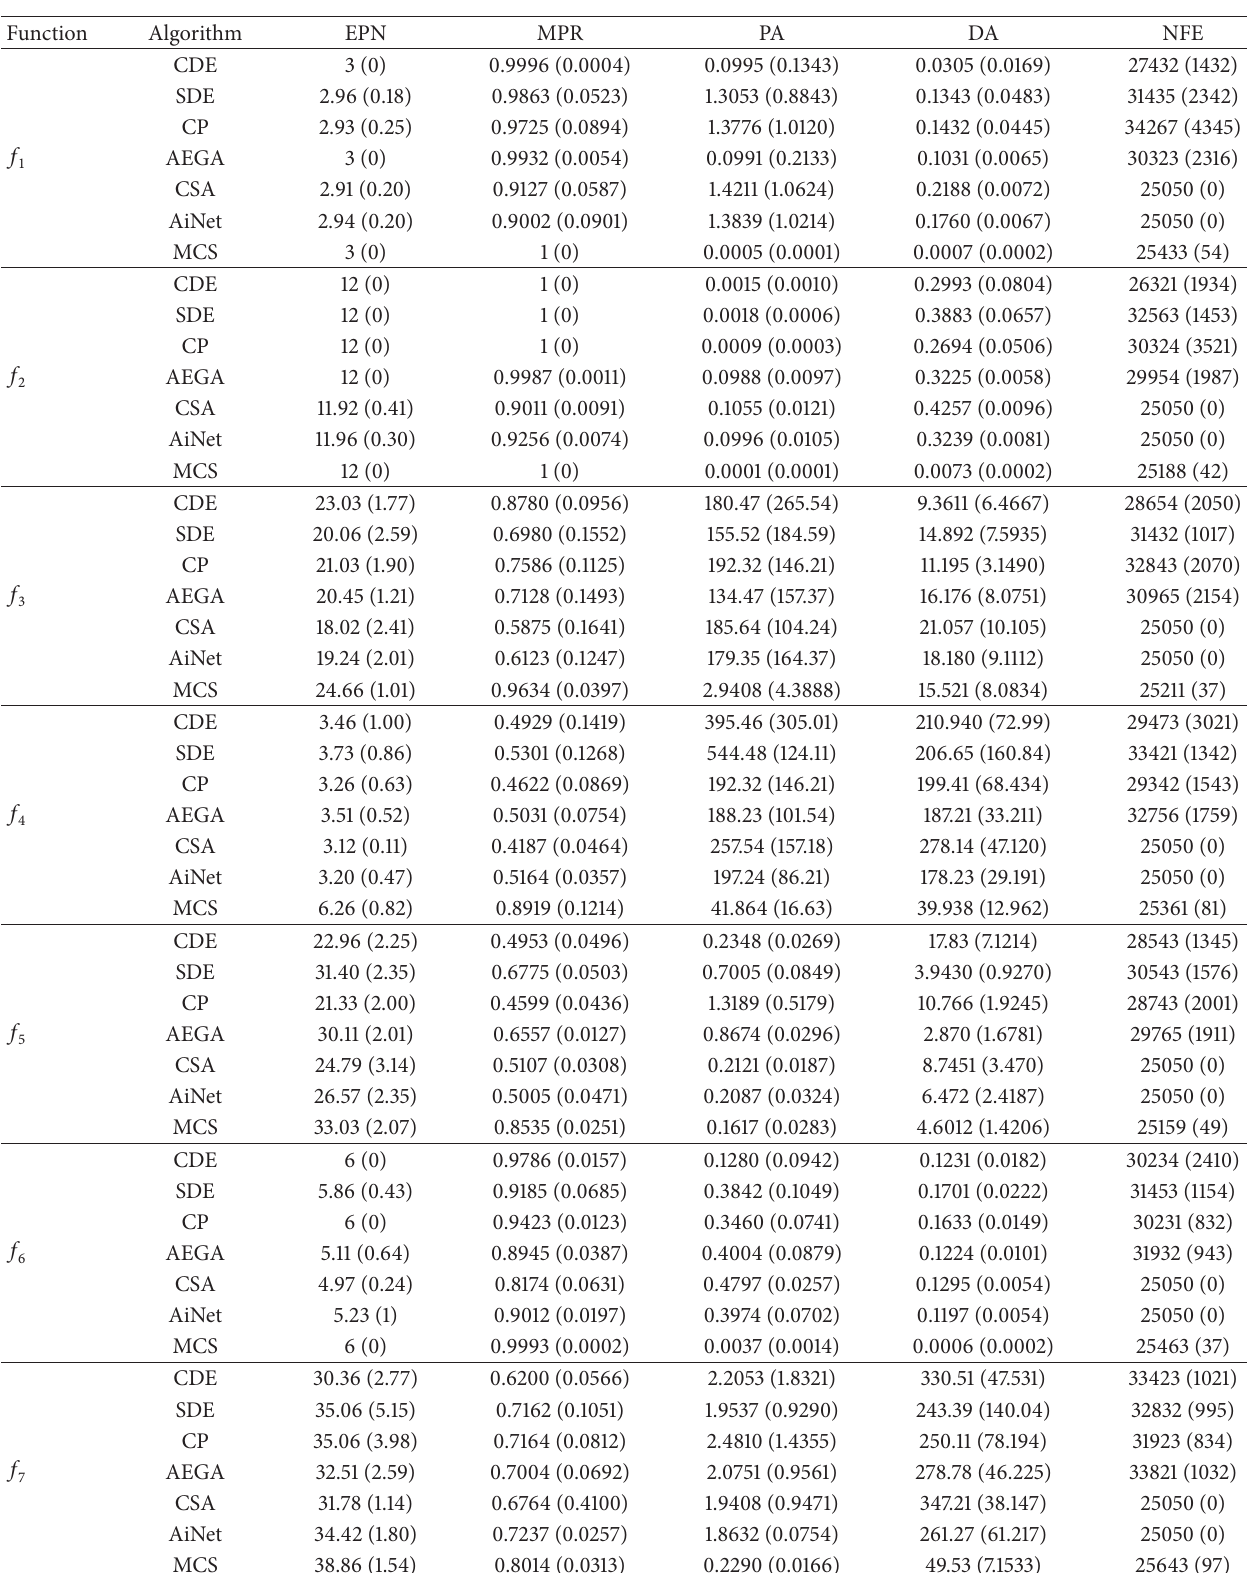
Table 1: Performance comparison among multimodal optimization algorithms for the test functions 𝑓 1 – 𝑓 7 . For all the parameters, numbers in parentheses are the standard